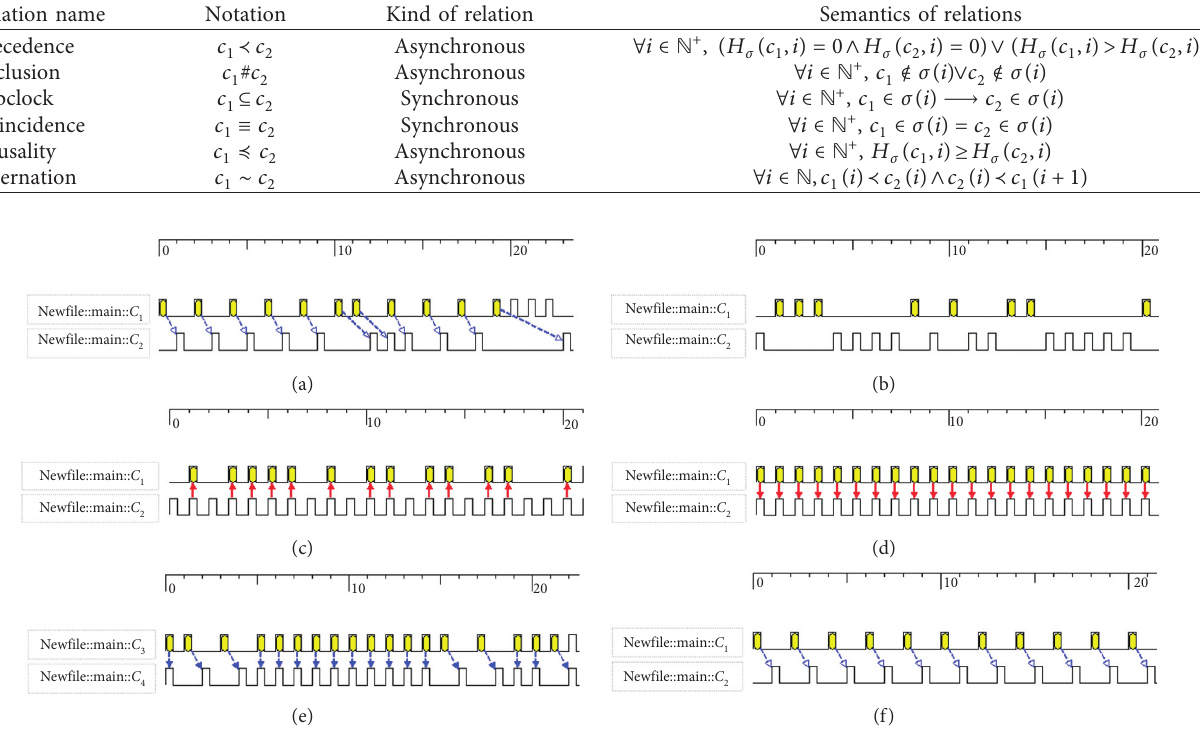
Figure 5: A possible schedule of clock relations: (a) c